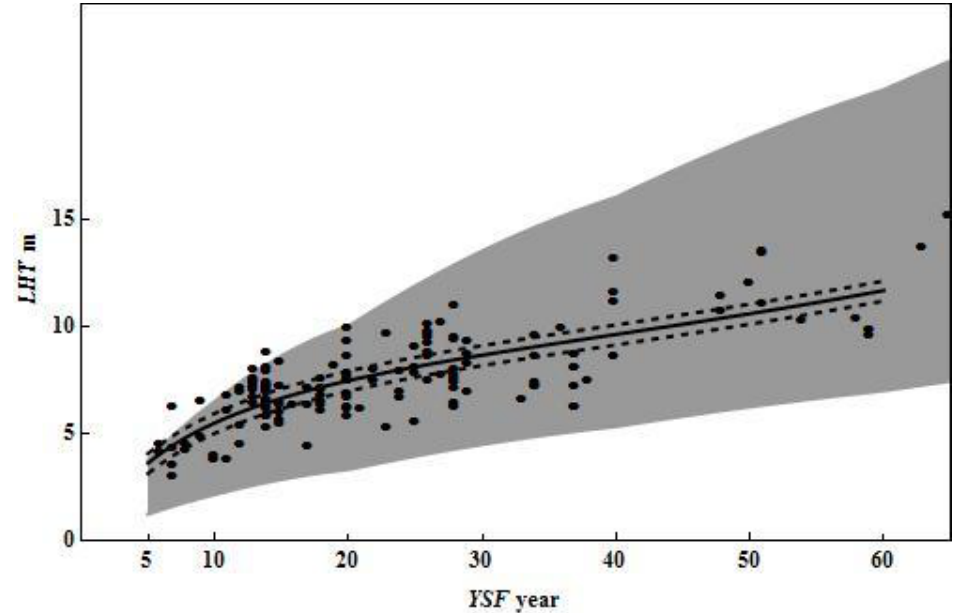
Figure 8. Trends in mean post-fire regenerated canopy heights across years since fire ( YSF ). Trends are estimated for the median (full line) and maximum and minimum latitude (dashed) of the fire locations. The fitted regression model is: 2 ˆ 0.057 3.83 0.36 0.0019 LHT LAT YSF YSF YSF      . = 0.78, = 90.12 ( P < 0.01). A 95% confidence interval for LHT determined from field plots located to the south of the studied fires is shaded in